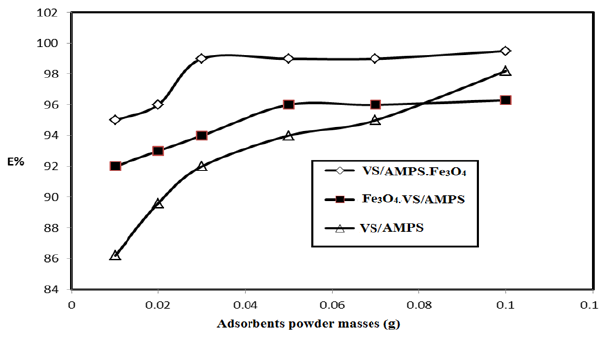
Figure 7. Effect of VS/AMPS cryogel and its magnetite composite contents on their MB removal efficiencies from water at room temperature.